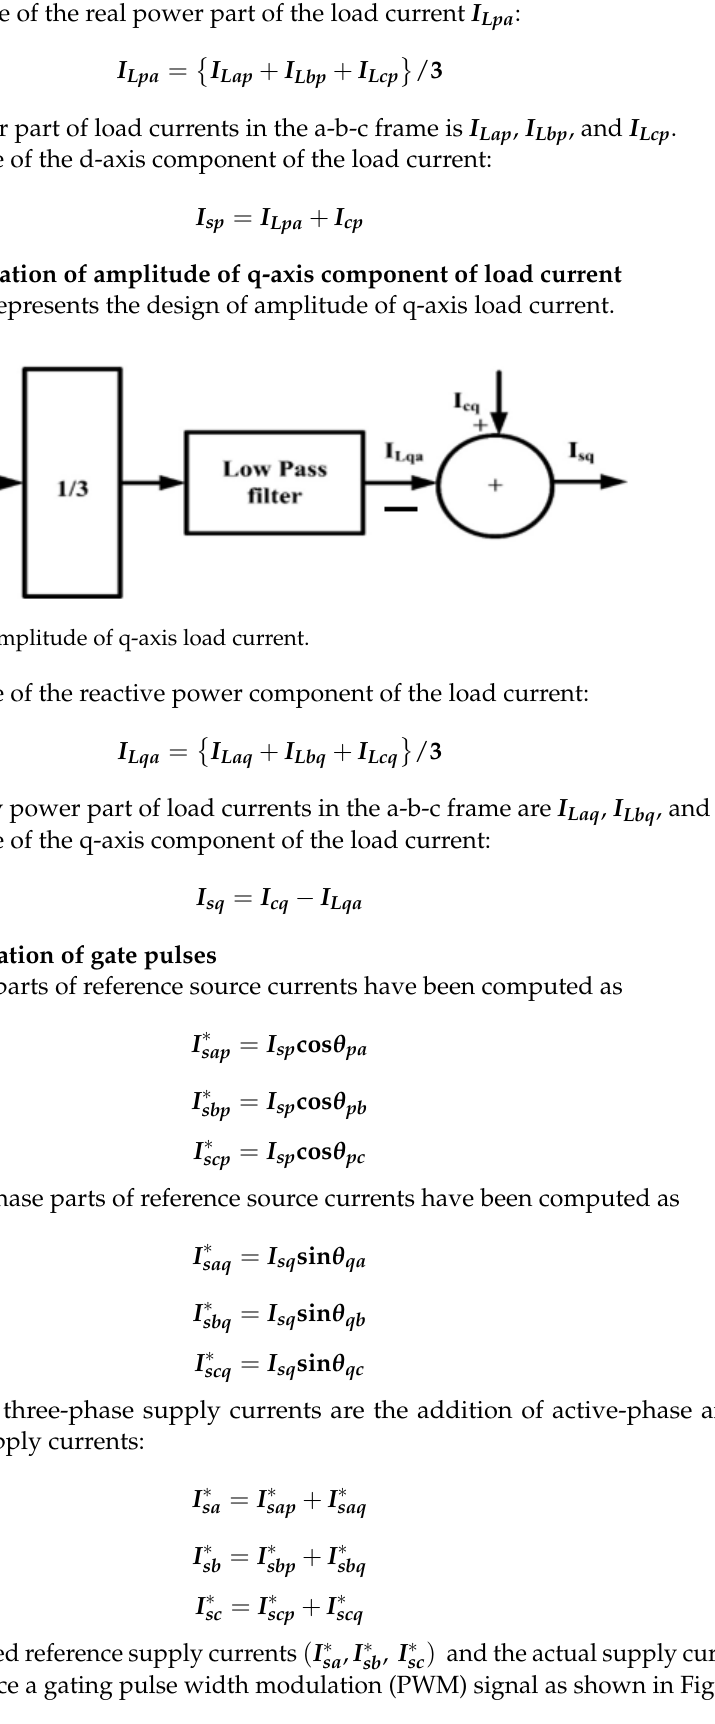
Figure 6. Design of amplitude of d-axis load current.